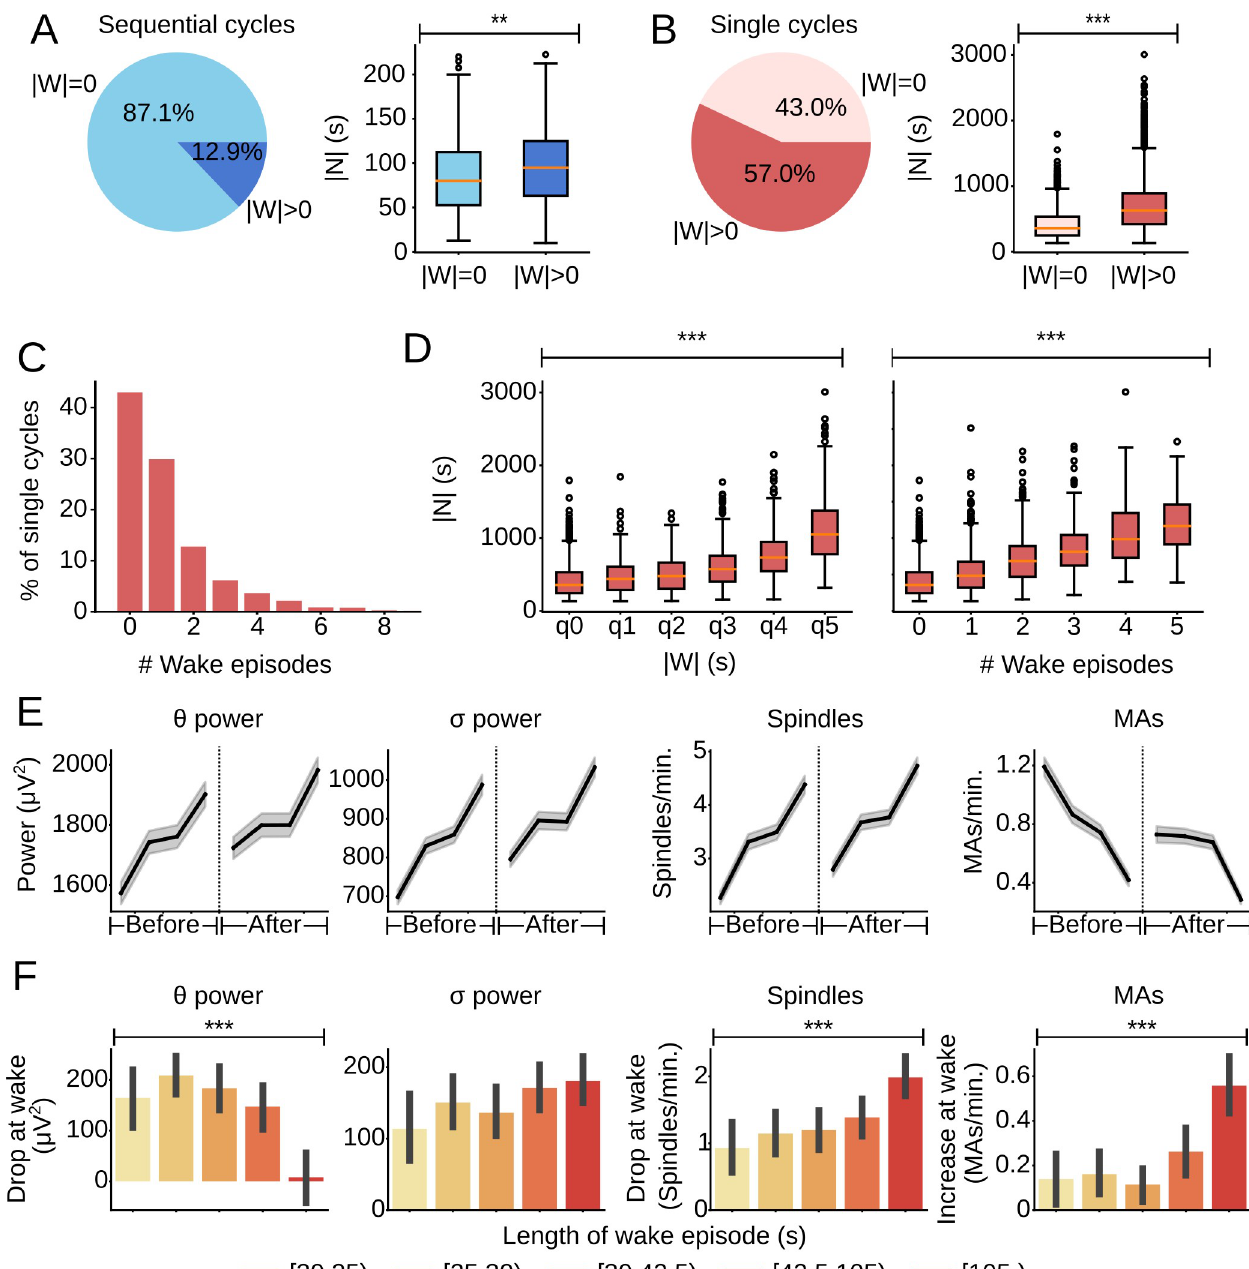
Fig 5. Relationship between wake episodes and NREM sleep during an inter-REM interval. (A) (Left) Pie chart indicating the percentage of sequential cycles without (|W| = 0) and with wake episodes (|W| > 0). (Right) Box plot comparing |N| for sequential cycles with and without wake episodes (t-test, t = -3.22, p = 0.0012, n |W| > 0 = 122, n |W| = 0 = 825 cycles). (B) (Left) Pie chart indicating the percentage of single cycles without and with wake episodes. (Right) Box plot comparing |N| for single cycles with and without wake episodes (Welch’s t-test, t = -28.64, p = 3.97e-163, n |W| > 0 = 2259, n |W| = 0 = 1702). (C) Bar plot showing the distribution of the number of wake episodes during the inter-REM interval of single cycles. Note that 99.63% of single cycles had 8 or fewer wake episodes. (D) (Left) Box plot comparing total NREM duration, |N|, for single cycles with increasing values of total wake duration, |W| (Welch’s ANOVA, F (5,1233.21) = 301.99, p = 3.78e-211). The x-tick q0 corresponds to cycles without wake. The remaining cycles with |W| > 0 were subdivided into quintiles, labeled q1—q5, based on the distribution of |W| for single cycles. (Right) Box plot comparing |N| for single cycles based on the number of wake episodes occurring during the inter-REM interval (Welch’s ANOVA, F(5,475.26) = 246.53, p = 1.65e-129). Note that 97.61% of single cycles contained 5 or fewer wake episodes. (E) Progression of θ power, σ power, spindle rate, and MA rate during NREM sleep before and after a wake episode. Only sequences with at least 1 minute of NREM sleep both before and after wake during the inter-REM interval of single cycles were included. The duration of NREM episodes was normalized. ‘Before’ refers to all NREM sleep in between either the previous REM or wake episode and the current wake episode. ‘After’ refers to all NREM